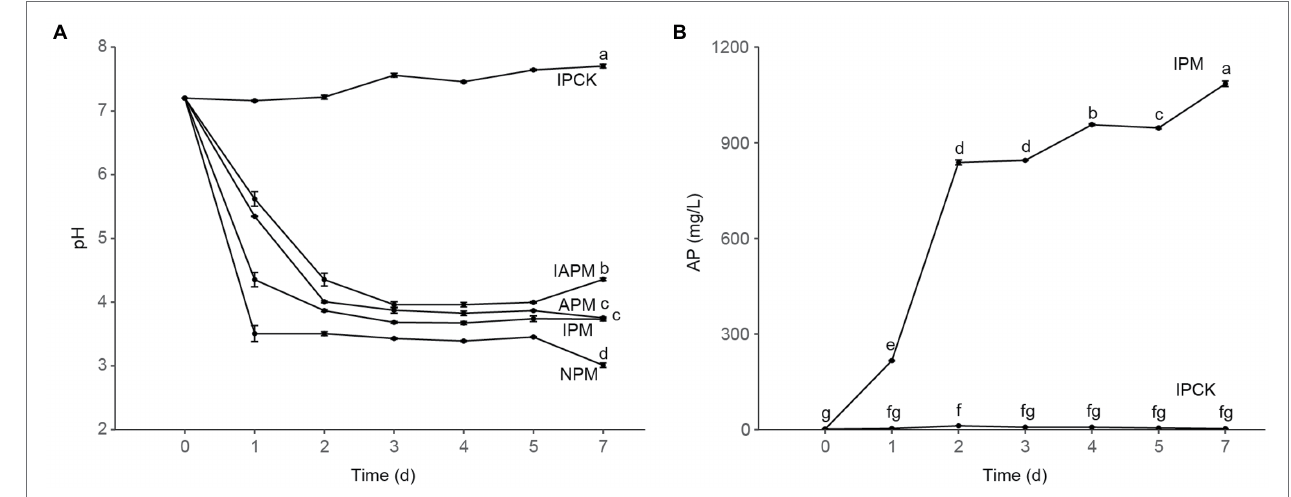
FIGURE 1 | The pH and solubilized available phosphorus (AP). (A) The change of pH in mediums with different phosphorus sources. Phosphate-solubilizing bacteria (PSB) FP12 was cultured in four kinds of media, i.e., insoluble phosphorus medium (IPM); available phosphorus medium (APM); insoluble and available